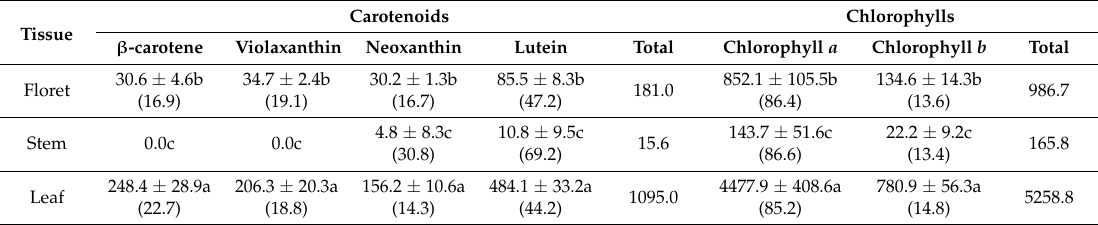
Table 2. Carotenoid and chlorophyll concentrations in the different broccoli tissues ( µ g/g DW).